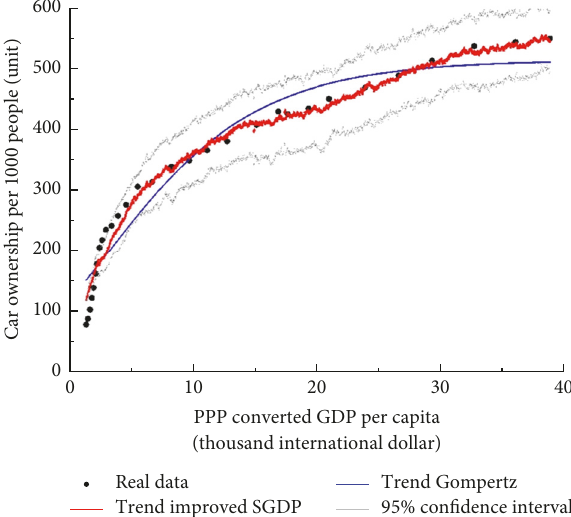
Figure 6: Real data versus Improved SDE Gompertz versus Trend Gompertz in Korea.